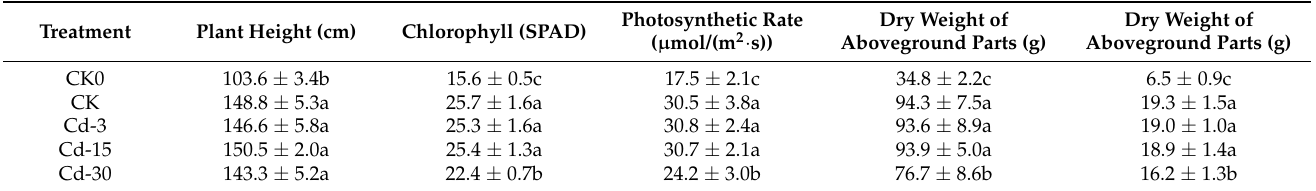
Table 2. Effects of different BSFL frass application on maize growth parameters.